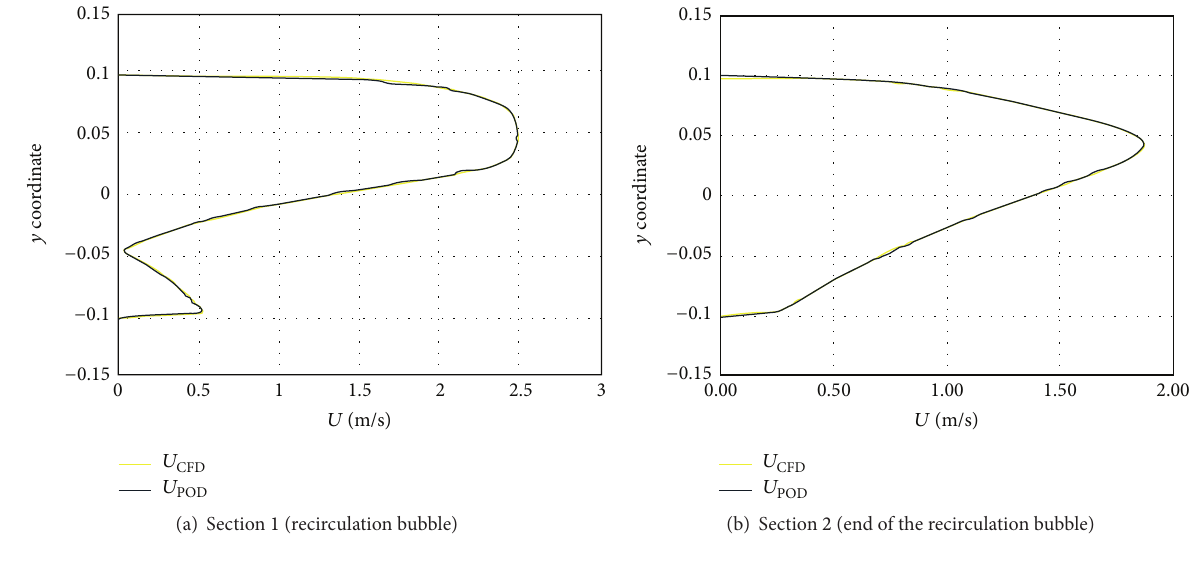
Figure 6: Backward facing step. Velocity magnitude profiles, 𝛼 = 70 ∘ .